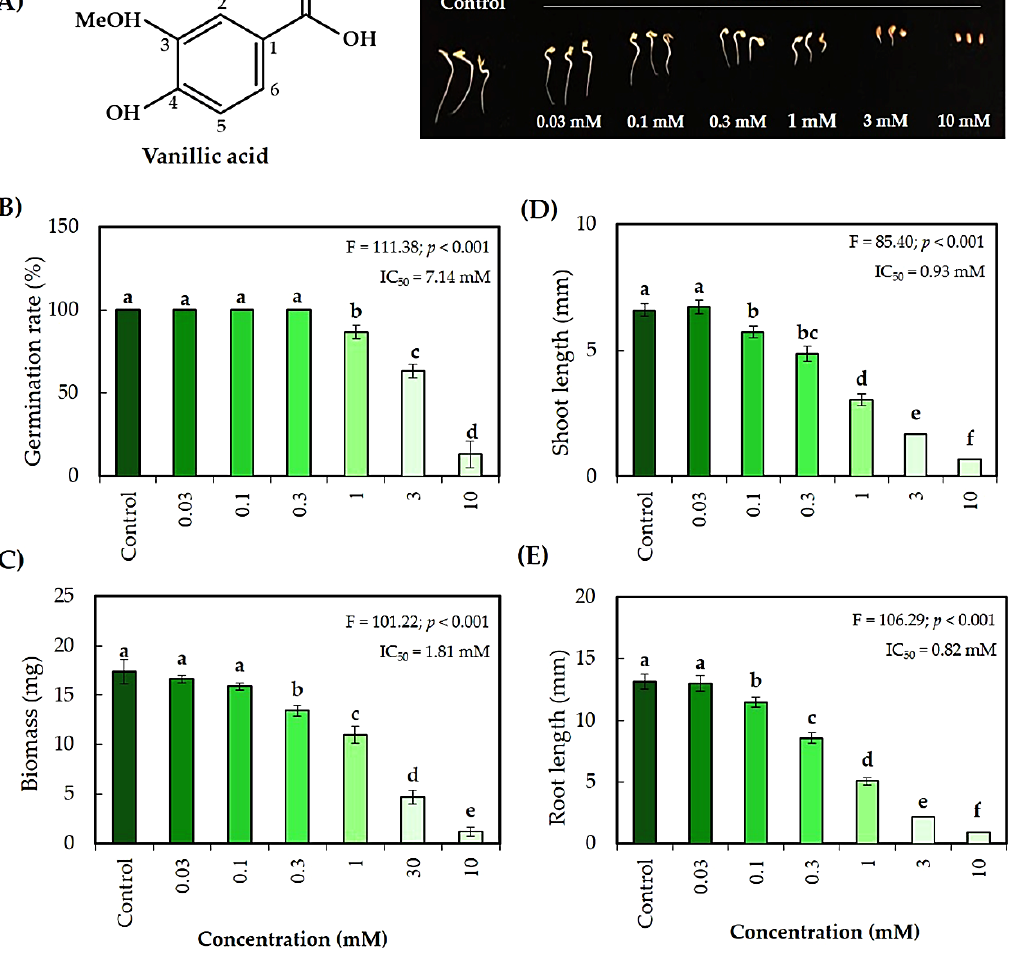
Figure 3. Growth inhibitory effects on Lepidium sativum exposed to vanillic acid isolated from the S. garrettiana leaf extracts. ( A ) L. sativum seedlings after 48 h of treatment, ( B ) seed germination, ( C ) dry biomass, ( D ) shoot length, and ( E ) root length. Values are the mean (±S.D.) of three replicates (n = 30); different letters on each bar indicate a statistically significant difference between treatments (Tukey’s HSD, at the 0.05 probability level) .